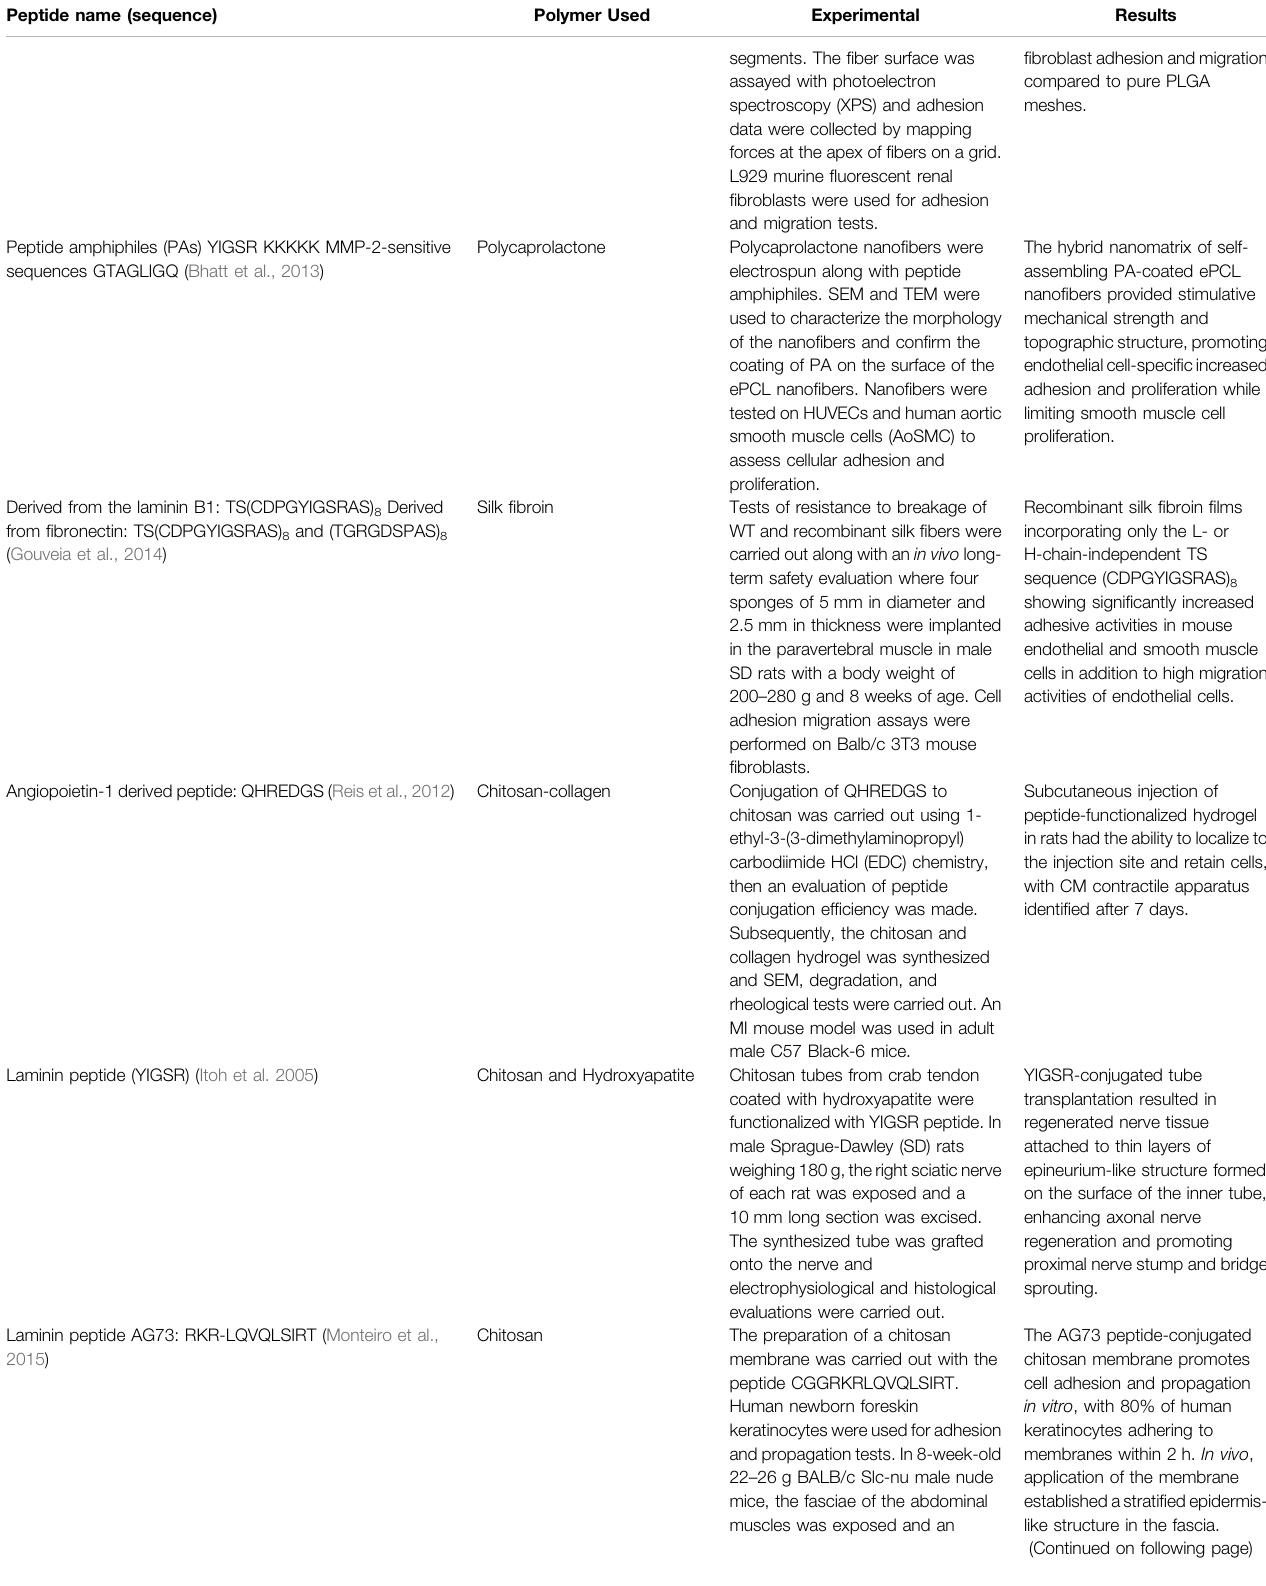
TABLE 1 | ( Continued ) Summary of peptide